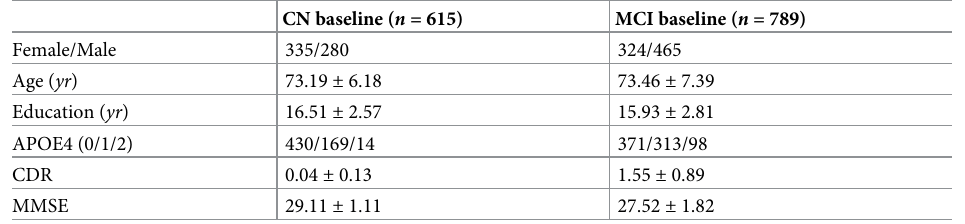
Table 1. Summary statistics of the participants at